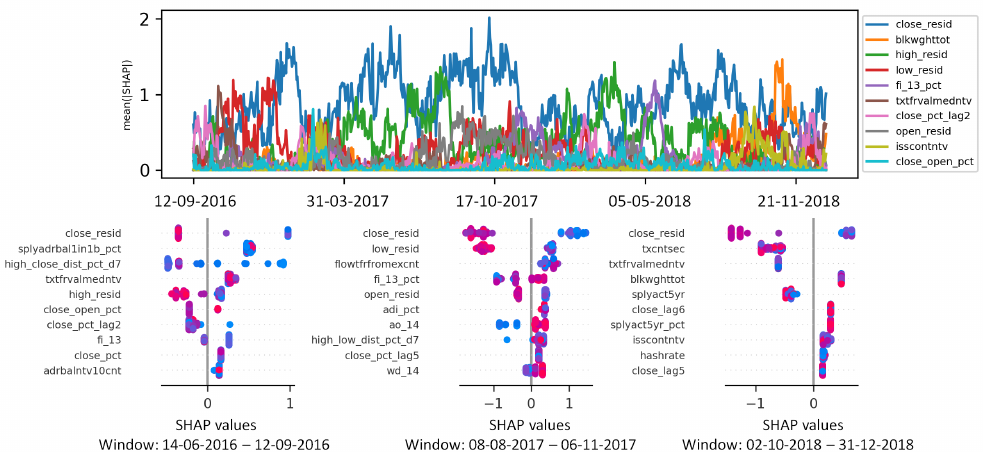
Figure 6. Interactive dashboard snapshot. Uptrend class. BTCUSD. Sliding training window size W = 90.